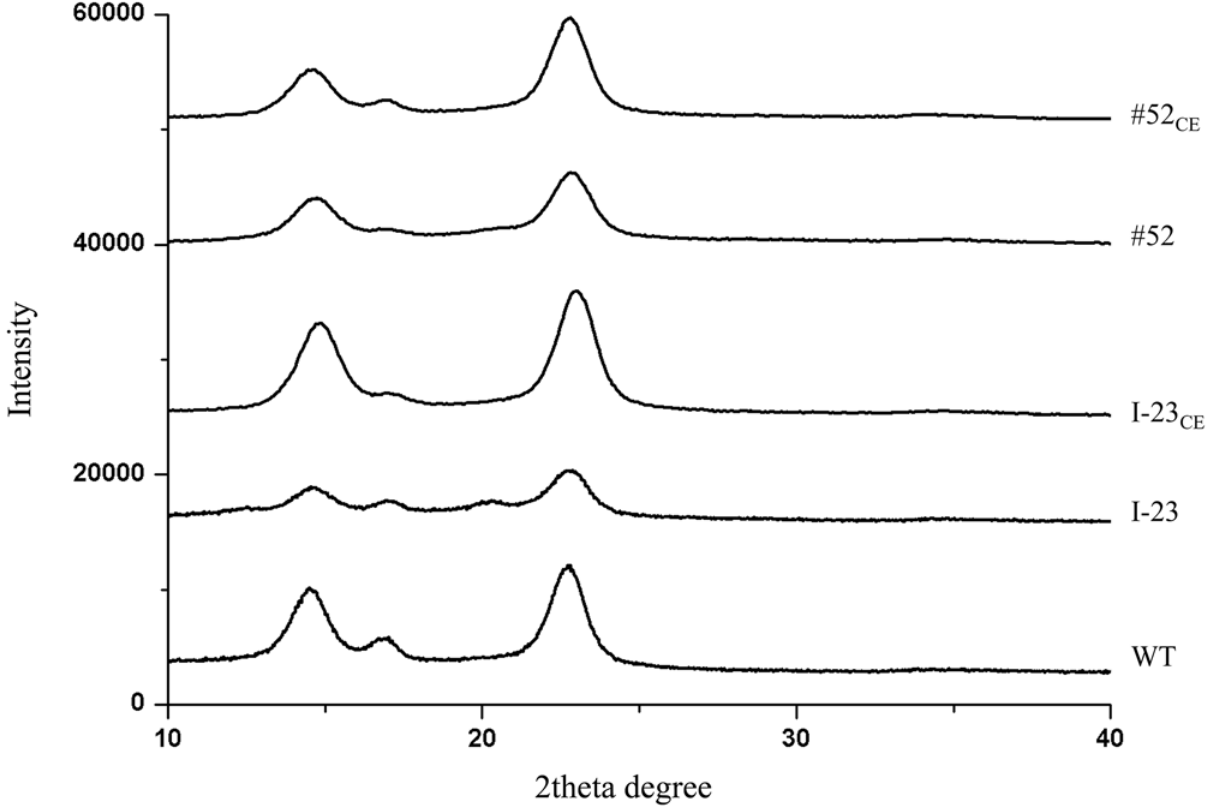
Fig 1. XRD diffractograms of cellulose morphology mutants I-23 and #52, their complemented transformants, I-23 CE and #52 CE , and wild type. For each mutant, complemented transformant and wild type, cellulose pellicles prepared from three biological replicates were used for analysis, and the result of one representative diffractogram is shown.